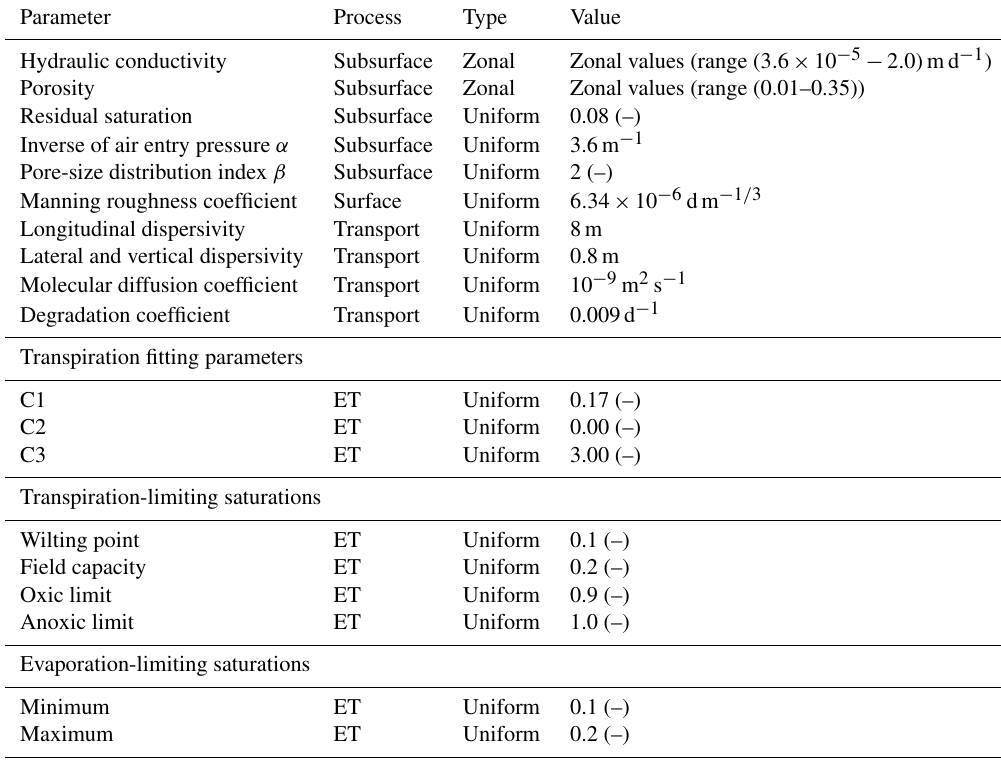
Table 1. The key flow parameters and their values following Yang et al.